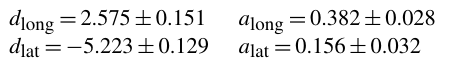
Table 2. The fitted parameters d and a to determine the location of the lunar intensity centroid from the observing geometry with Eq. (1). d long = 2.575 ± 0.151 a long = 0.382 ± 0.028 a lat = 0.156 ±